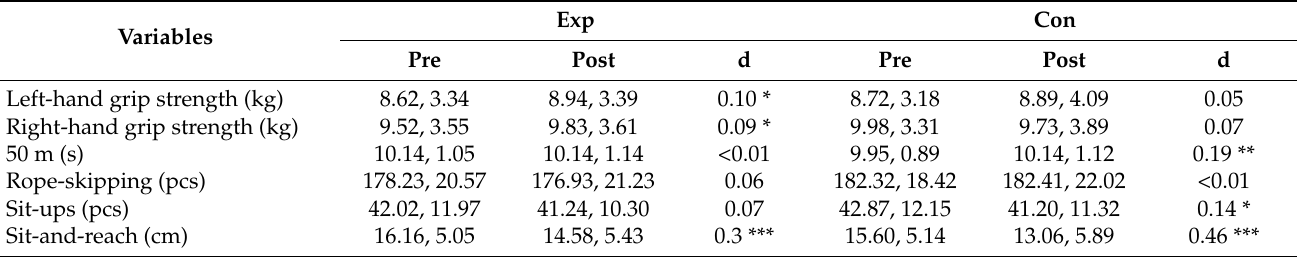
Table 5. Descriptive statistics of the physical fitness variables (mean, standard deviation); within- group